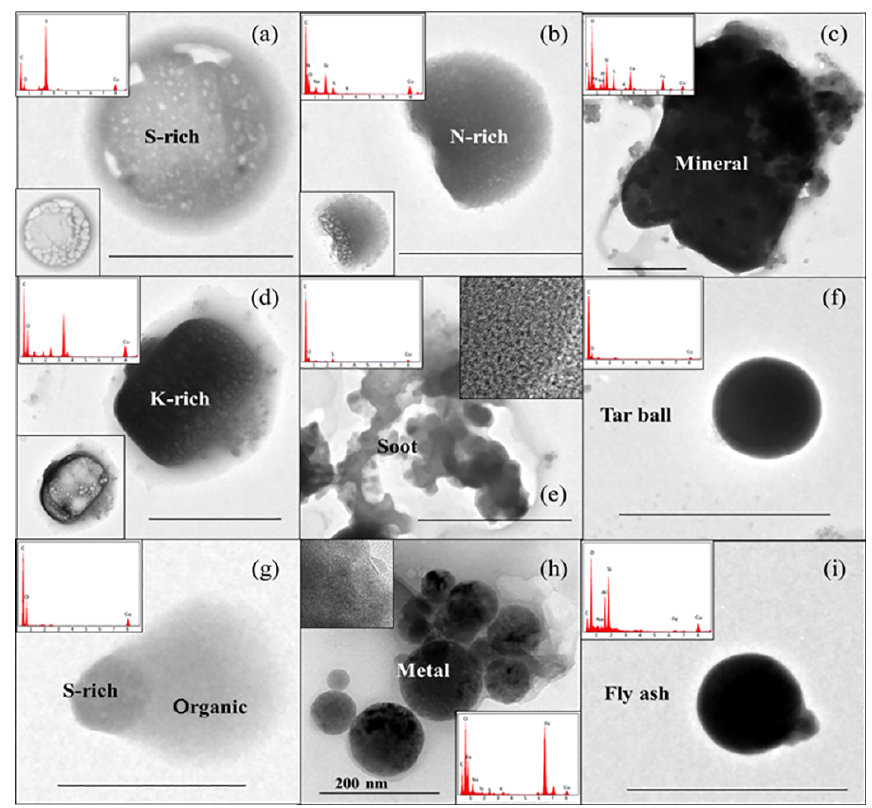
Figure 4. Nine categories of particles under the TEM view. The inserted spectra are obtained by the EDS, and the grid-like images are acquired from the selected-area diffraction. (a) S-rich, (b) N-rich, and (c) mineral. (d) K-rich, (e) soot, (f) tar ball, (g) organic, (h) metal, and (i) fly